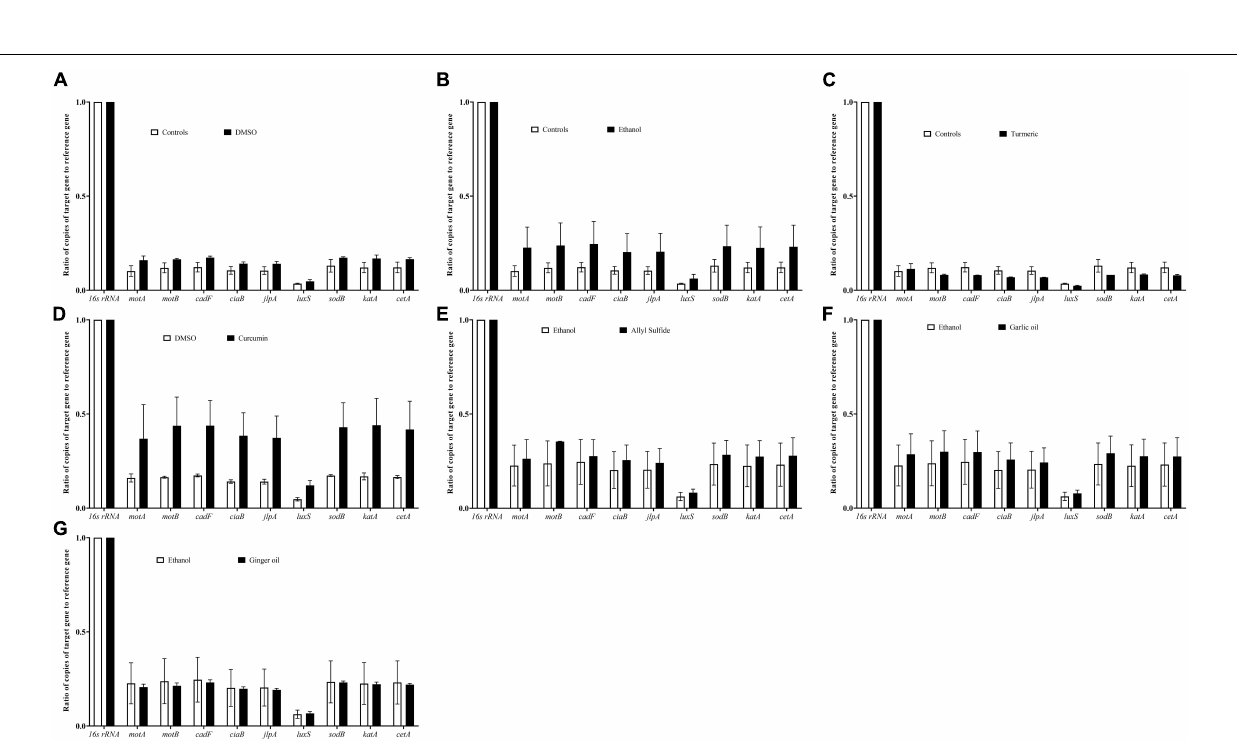
Frontiers in Microbiology |